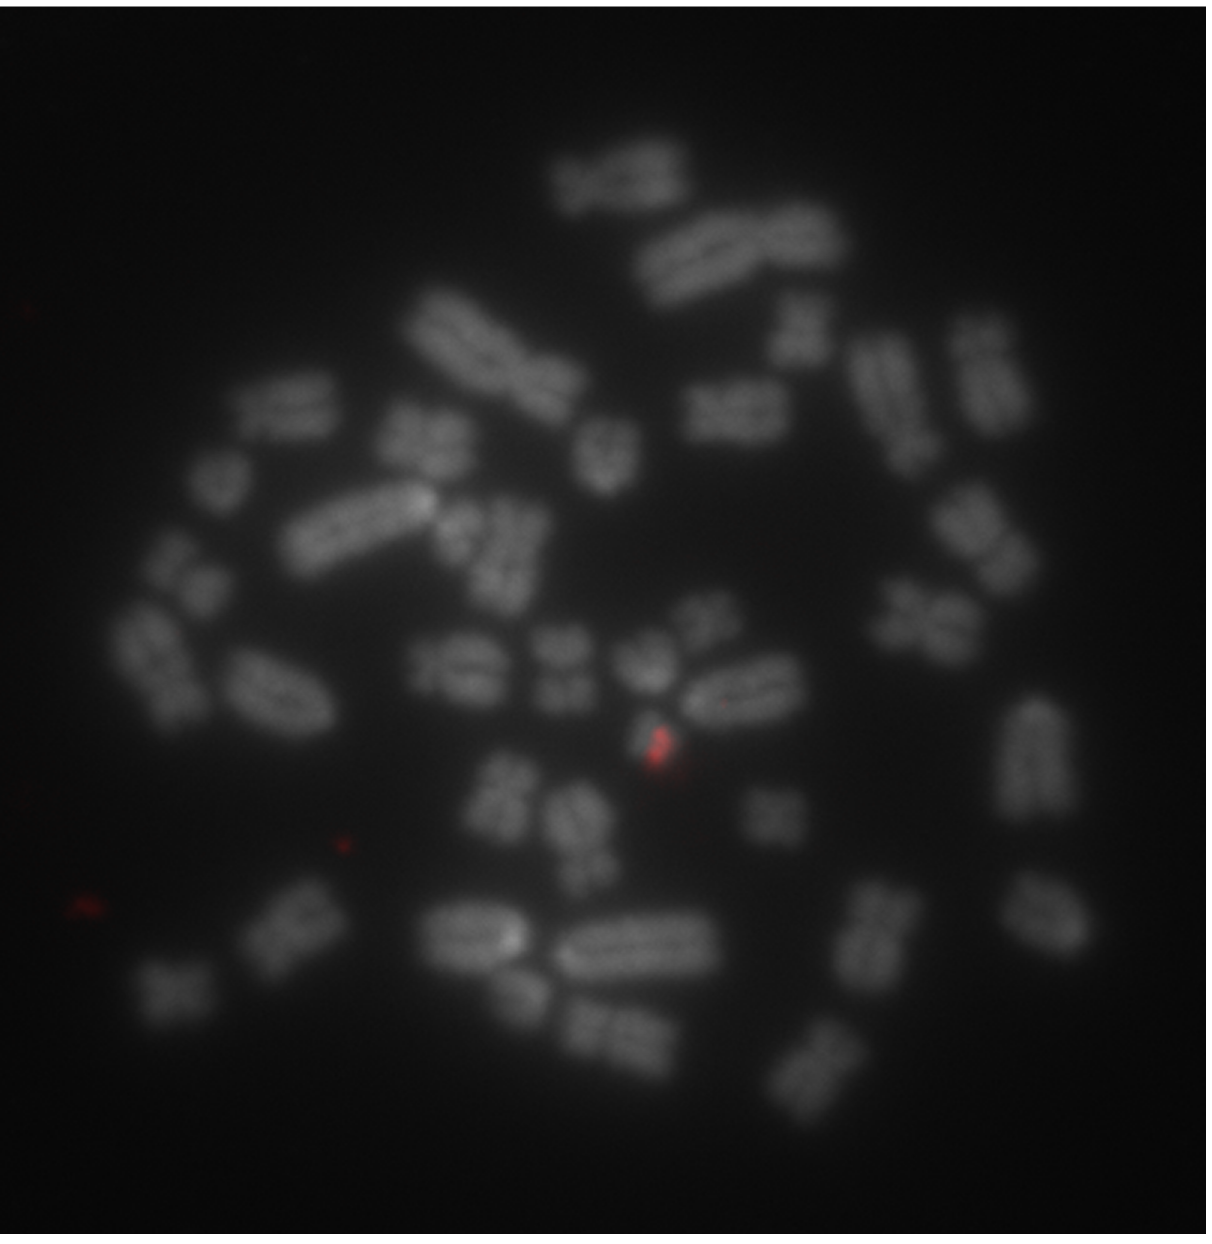
Fig 4. Y-chromosome specific fluorescence in situ hybridization signal of FISH probe#1 – 5 with Tyramide signal detection on a boar metaphase. DAPI stained metaphase chromosomes are converted grayscale and AF594 hybridization signal on the short arm of the Y-chromosome is